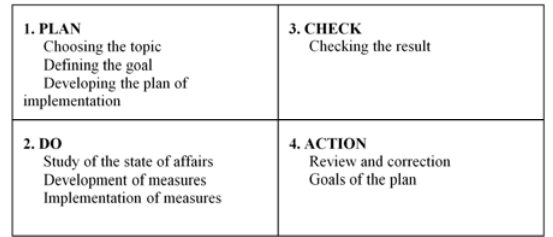
Fig. 2. Deming Cycle covering the entire management